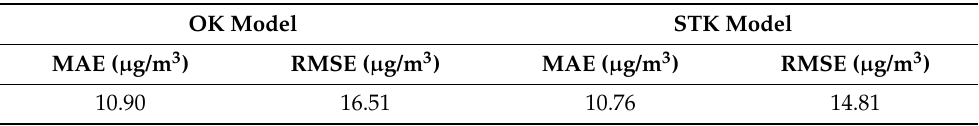
Table 2. Comparison of error analysis between Ordinary Kriging (OK) model and Spatial-Temporal Kriging (STK) model.